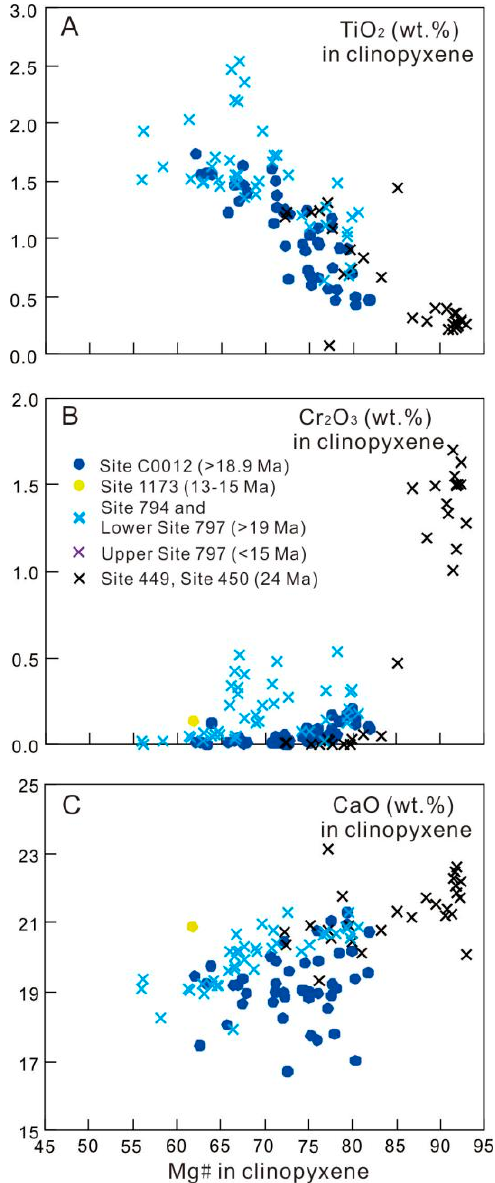
Figure 5. Clinopyroxene compositional plots of Mg# versus TiO 2 wt.% ( A ); Mg# versus Cr 2 O 3 wt.% ( B ); Mg# versus CaO wt.% ( C ) for the Site C0012 and 1173 volcanic rocks from Shikoku Basin, the Site 449 and 450 peridotites from Parece Vela Basin, and the Site 794 and Site 797 volcanic rocks from Japan Sea. Data sources as for Figure 4.